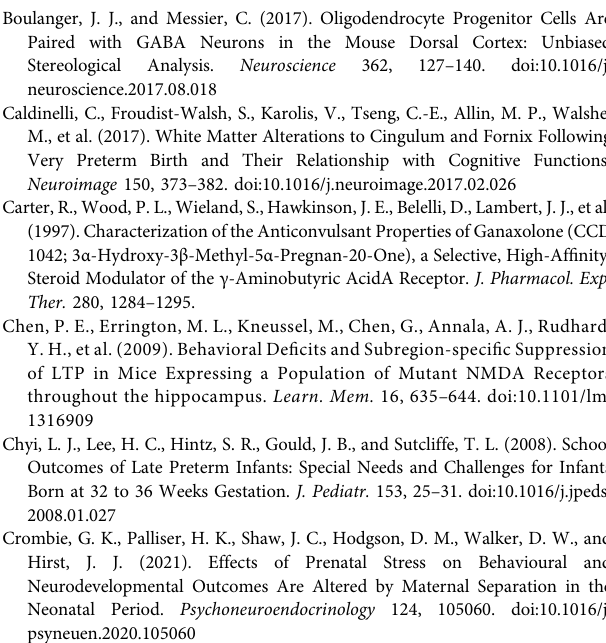
Supplementary Figure S1 | Preterm survival from birth until term equivalence (7 days since birth) for (A) males and (B) females receiving no treatment (control), vehicle (45% b-cyclodextrin), 0.5 mg/kg ganaxolone (low dose), 1.0 mg/kg ganaxolone (mid dose), or 2.5 mg/kg ganaxolone (high dose). Group numbers at birth to TEA were control (males = 11 – 7; females = 9 – 7), vehicle (males = 11 – 6; females = 8 – 6), low (males = 8 – 6; females = 7 – 6), mid (males = 9 – 6; females = 9 – 6), and high (males = 8 – 6; females = 10 – 5). SupplementaryFigureS2| Fractional weight gain (A,B) , ponderal index (C,D) , supplemental feeding (E,F) , and wellbeing score (G,H) was recorded from birth (days since birth 0) until term equivalence (postnatal age 7) for male (A,C,E,G) and female (B,D,F,H) preterm neonates receiving vehicle (45% β - cyclodextrin; diamond; males n = 6, females n = 6) and compared to control (circle; males n = 7, females n = 7) preterm neonates. Data presented as means ±